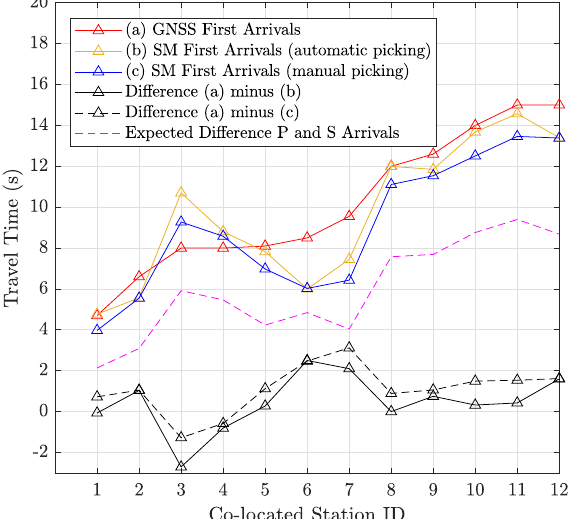
Figure 4. Seismic travel times (w.r.t. reference origin time), and the differences in travel times of GNSS versus the seismometer arrivals. The purple line shows the expected time difference of P and S arrivals. A small delay of the GNSS arrivals can be seen. Almost exclusively, first arrivals could be assigned to P-phase